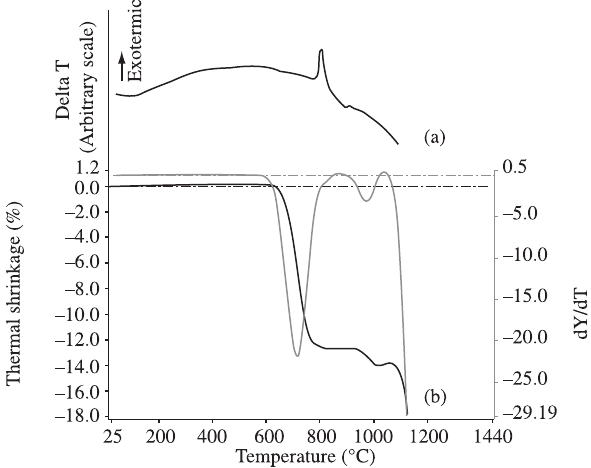
Figure 4. Thermal analysis of the investigated composition: (a) differential thermal analysis and (b) thermal shrinkage.